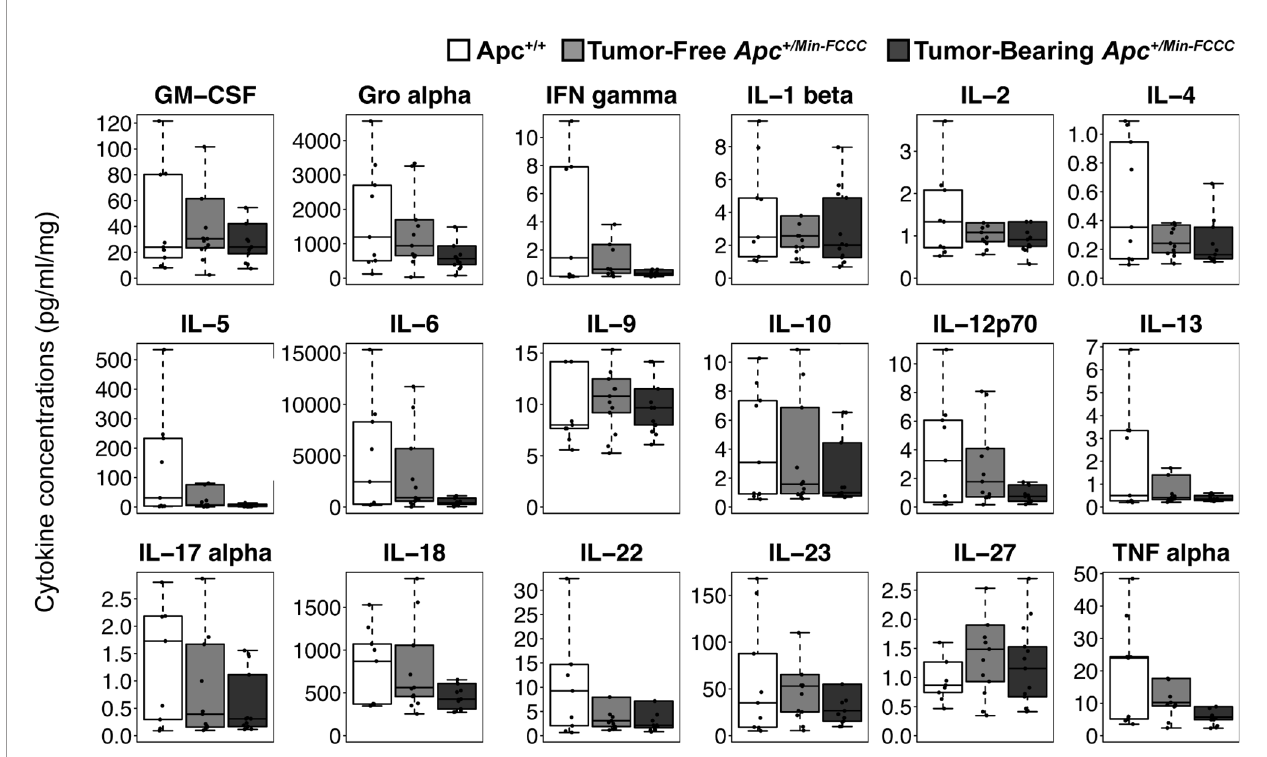
FIGURE 6 | Expression of cytokines involved in Th1, Th2, Th9, and Th17 signaling in nonneoplastic colon tissue from Apc +/+-FCCC wild type (white; n=9), tumor-free Apc +/Min-FCCC (light gray; n=13), and tumor-bearing Apc +/Min-FCCC (dark gray; n=13) mice. Boxplots depict the cytokine concentration in media (pg/ml) normalized to mass of colon tissue (mg) cultured from each mouse. Outlying data points (>3rd quartile + 1.5 x interquartile range) are omitted; all data points are shown in Supplemental Figure 7 . Fold change in median cytokine expression in tumor-bearing tumor-free = 0.4 – 0.9; Mann Whitney p ≥ 0.06; p=1.00 after adjusting for multiple